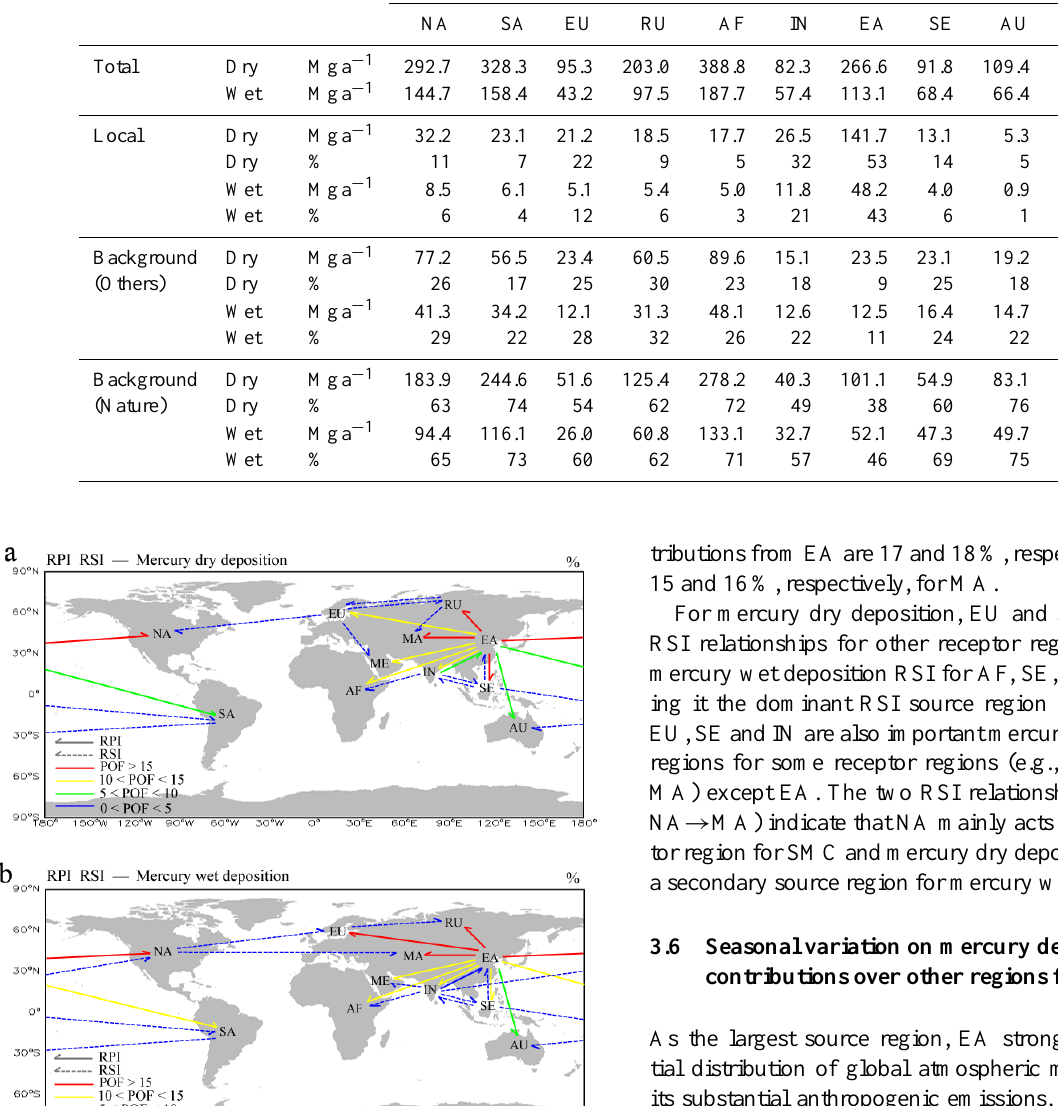
Table 2. Contributions from local and foreign sources to dry and wet deposition over each receptor region. The categories are defined same as Table 1. Sources